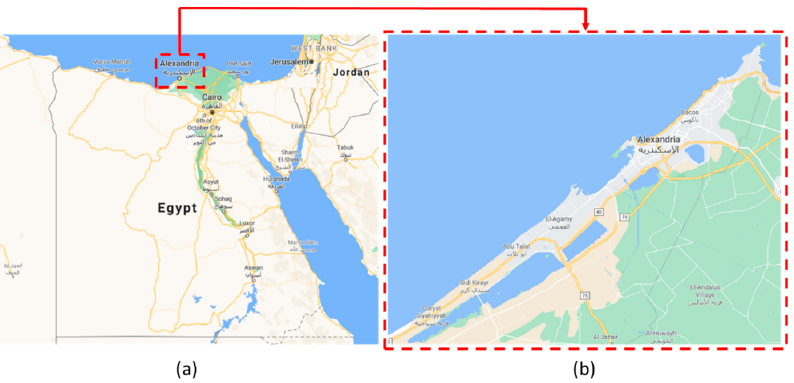
Figure 3. The location of Alexandria in Egypt. ( a ) Map of Egypt. Source: (GoogleMaps n.d.). ( b ) Alexandria map. Source: (GoogleMaps n.d.).